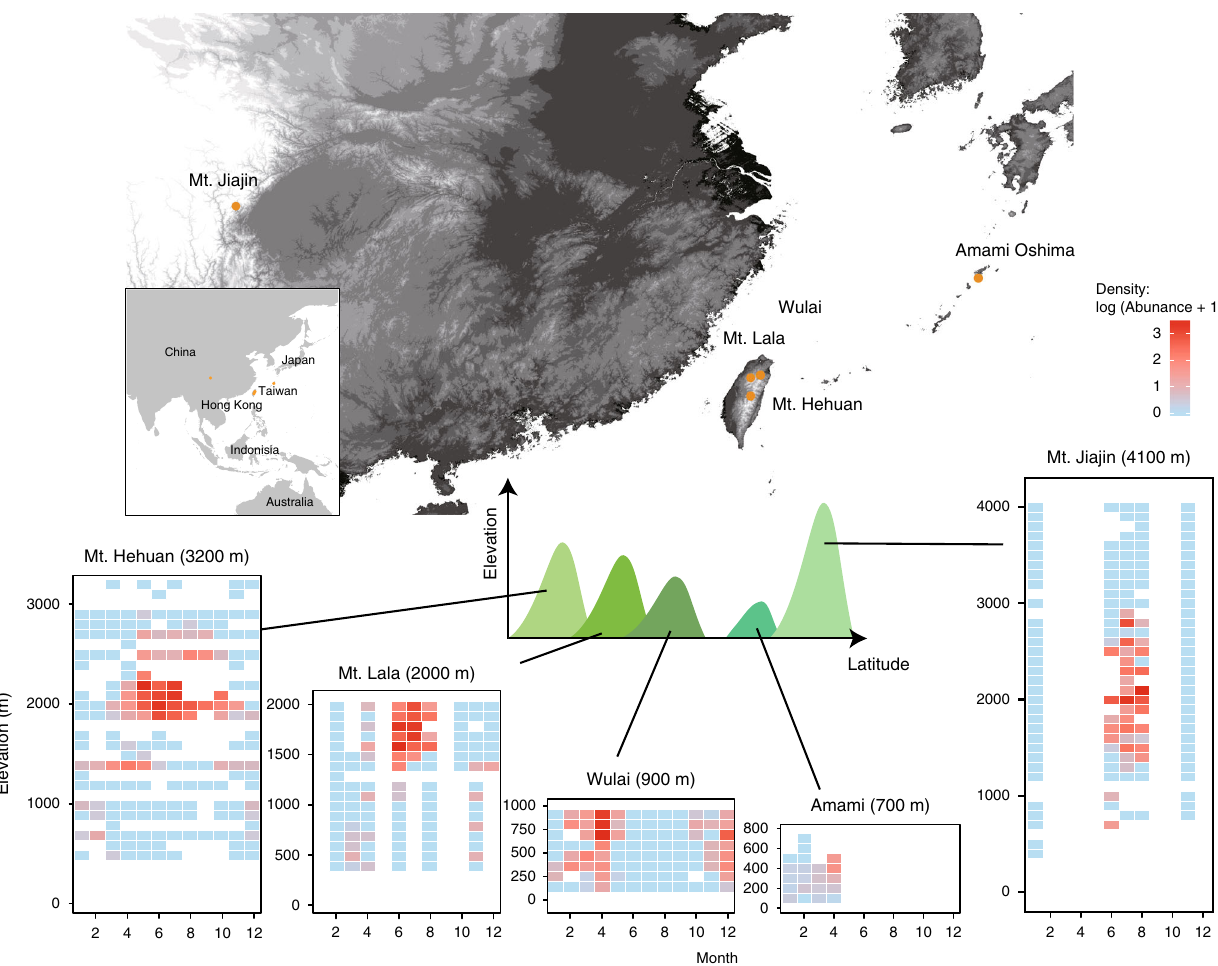
Fig. 2 Map depicting the mountain ranges sampled and heatmaps of the spatial – temporal distributions of population density along the elevational gradient at each location. Abundance values were log-transformed according to the formula log (amount + 1). The color scale indicates the difference in the abundance of beetles at the fi ve mountain ranges. The maximum elevation of each mountain range (indicated on the map by orange circles) is given in parentheses. The numbers of the beetles collected in total: Mt. Hehuan: n = 1791; Mt. Lala: n = 347; Wulai: n = 498; Amami: n = 144 ; and Mt. Jiajin: n = 517 . Maps were created based on the silhouettes from Farr et al. 69